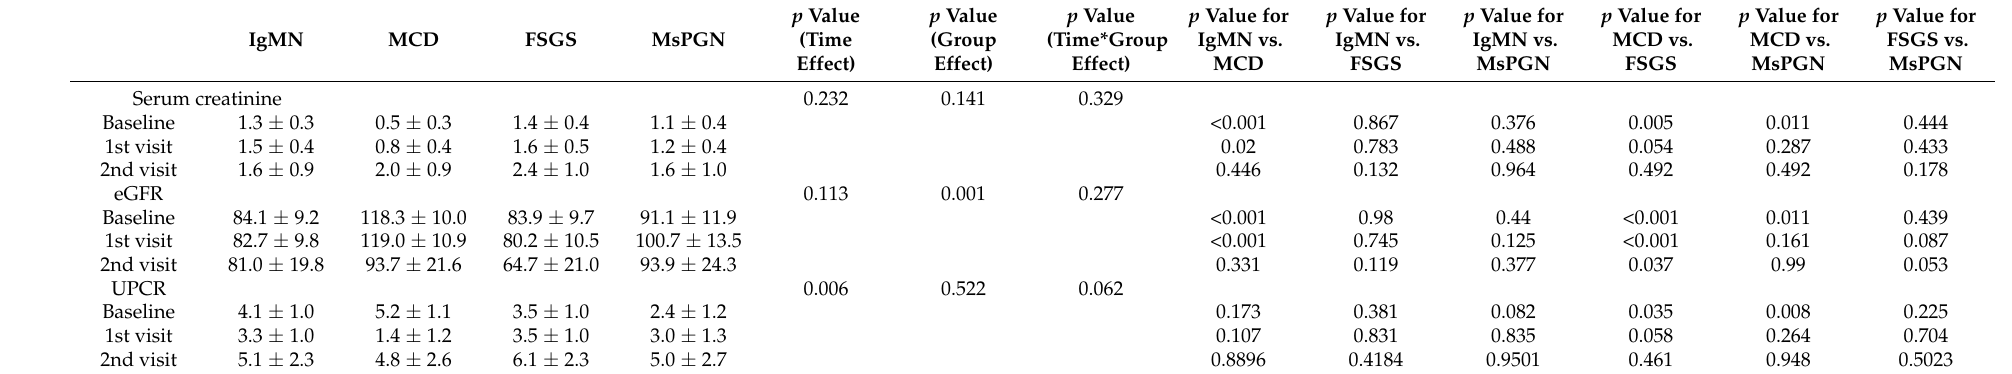
Table 3. Renal outcome during the follow-up after kidney biopsy.